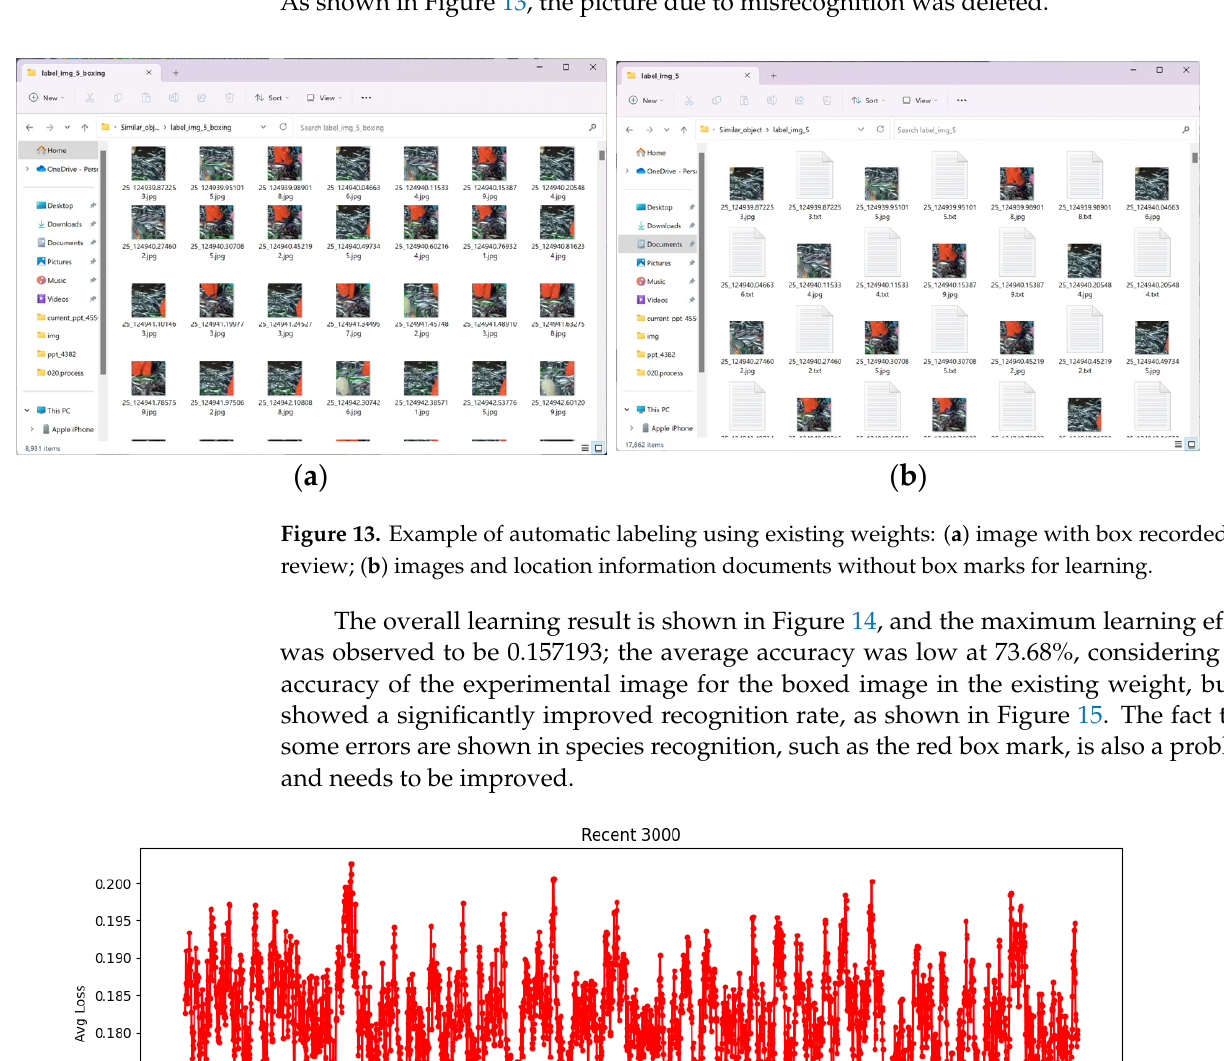
Figure 14. Loss average result over 3,000 units.